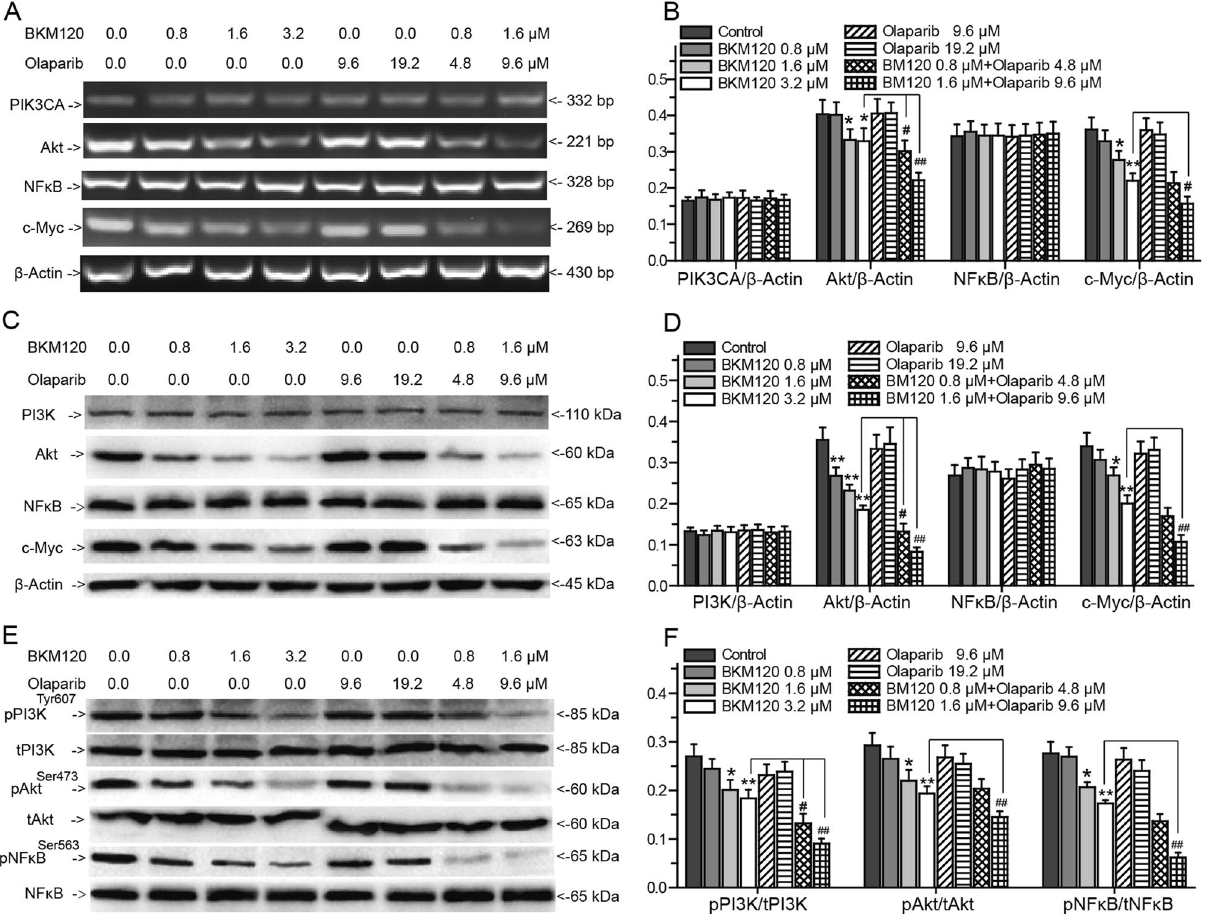
Figure 5. Effects of BKM120 and olaparib on the PI3K/Akt/NFκB/c-Myc signaling pathway. Effects of BKM120, olaparib, and a combination of BKM120 and olaparib on the expressions of PI3K, Akt, NFκB and c-Myc in MDA-MB-231 cells analyzed by ( A ) RT-PCR and western blots ( C ). ( E ) Effects of drugs on the phosphorylation of PI3K, Akt, and NFκB analyzed by western blots. Relative intensity expression obtained from the corresponding ( B ) RT-PCR and ( E,F ) western blots. Error bars represent SEM from the mean of three separate experiments. * P < 0.05 and ** P < 0.01 compared to control, # P < 0.05 and ## P < 0.01 compared to 3.2 μM BMK120-treated